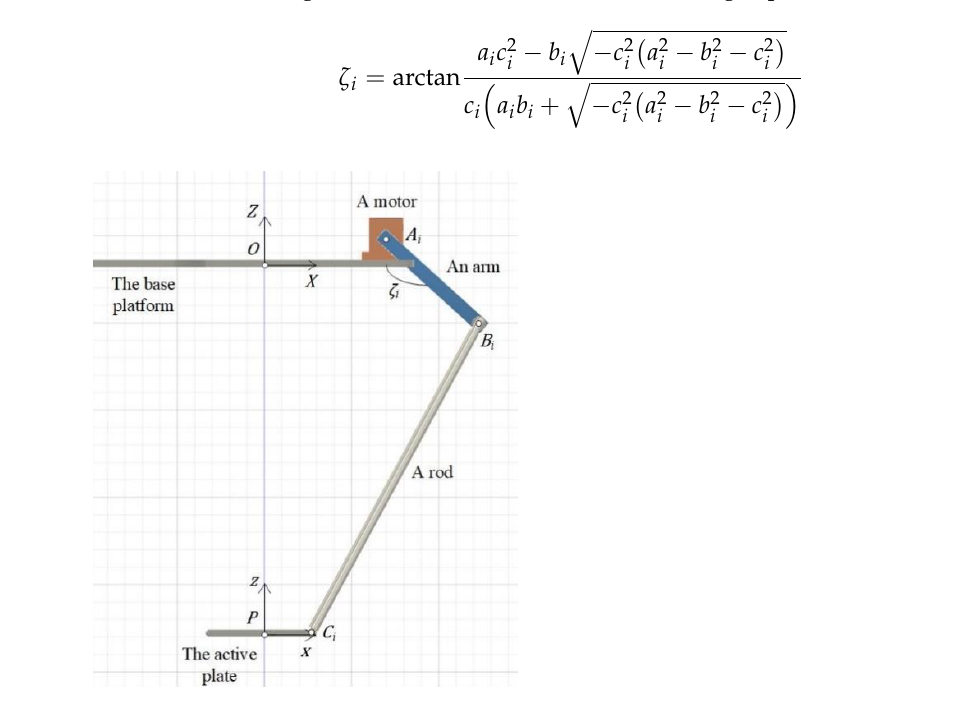
Figure 2. A kinematics chain of the Hexa robot.